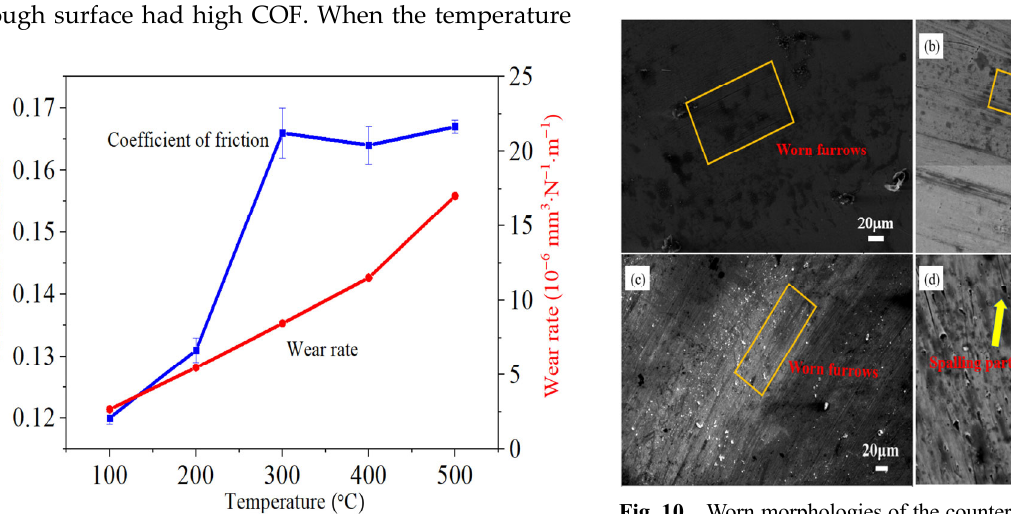
Fig. 10 Worn morphologies of the counter steel ball against 37% C f /LAS composites at different temperature: (a) room temperature, (b) 200 °C, (c) 300 °C, and (d) 400